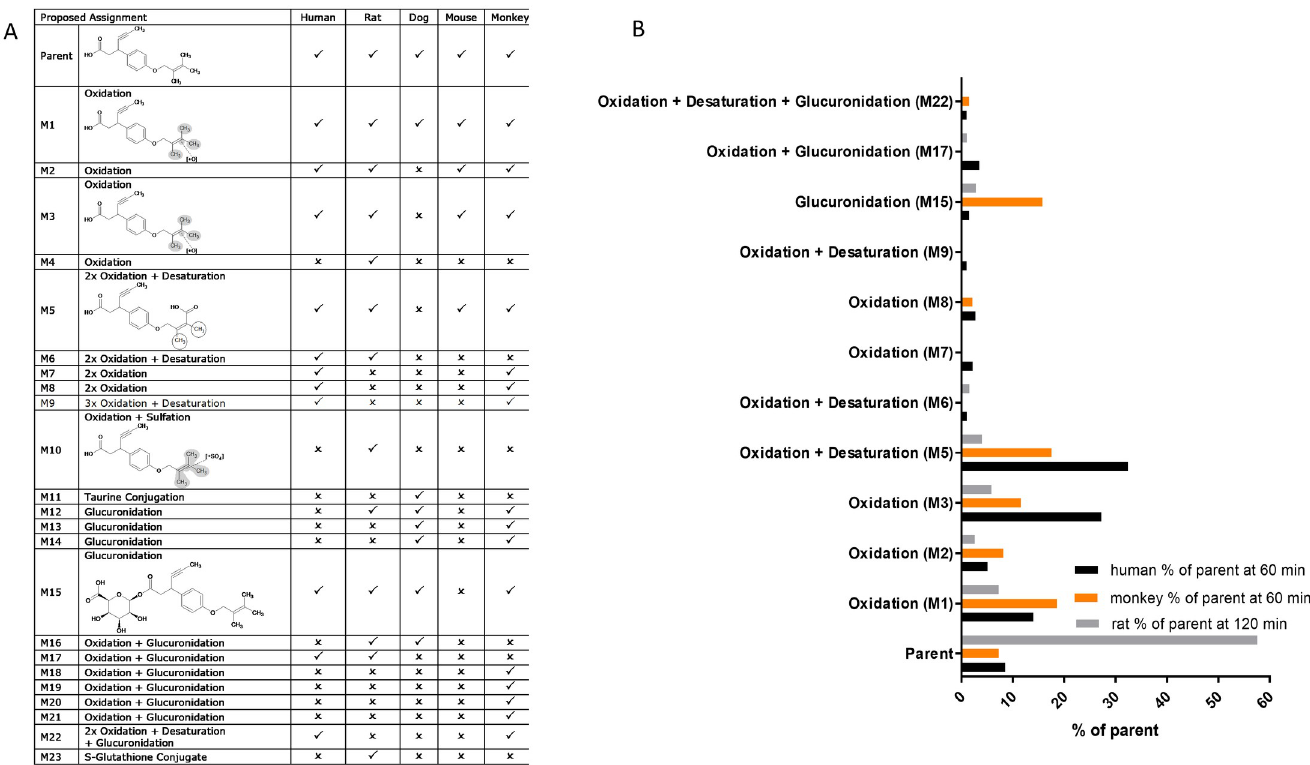
Fig 3. Metabolic profiling of CPL207280. Qualitative characterization of subsequent metabolites (A) and quantitative analysis (B). Data show the percent of the parent compound after incubation time. Human, monkey and rat hepatocytes were exposed to 10 μ M concentration of the compound for the time determined by T 1/2 in the given species. That is: for 60 minutes for human and monkey and 120 minutes for rat hepatocytes. Next, the supernatant was collected and metabolic changes of the parent compound were identified using UPLC followed by LC-MS/MS.